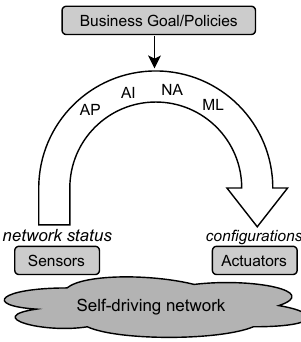
Figure 1. Closed